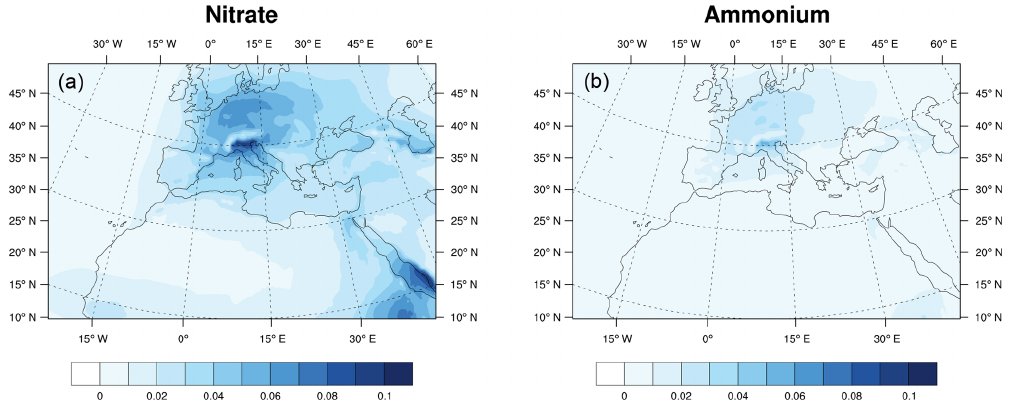
Figure 7. Optical depth of nitrate (a) and ammonium (b) at 550nm simulated by ALADIN-Climate over the period 2001–2016 (NIT simulation). Table 5. Seasonal averages and annual mean total AOD 550 simulated by ALADIN-Climate for NIT and REF configurations and measured by MODIS and MISR over the period 2001–2016 (2003–2016 for MODIS Aqua). AREA Period REF NIT NIT_2 NIT_3 MISR MODIS Aqua MODIS Terra Europe DJF 0 . 08 ± 0 . 01